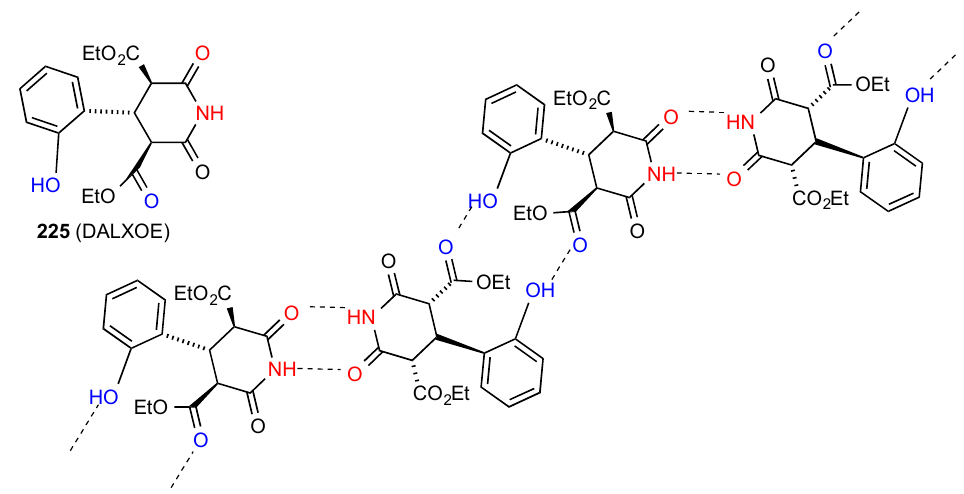
Figure 68. Structure adopted by compound 225.